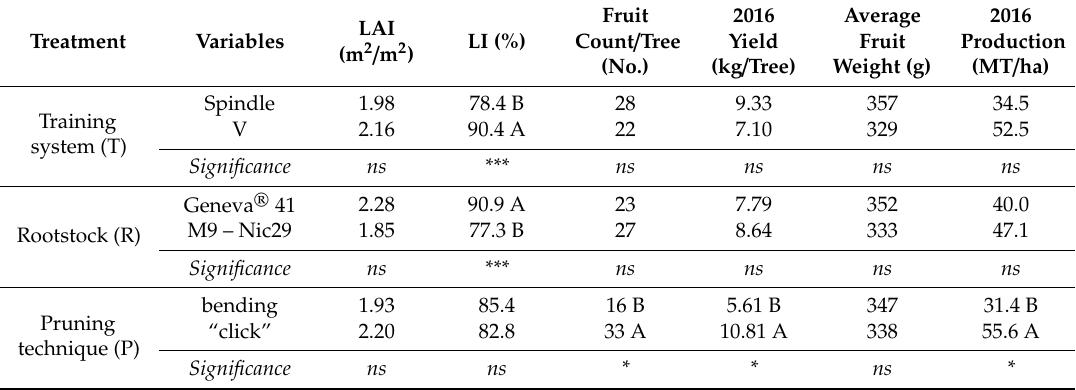
Table 1. The e ff ects of the training system, rootstock, and pruning technique on leaf area index (LAI) (m 2 / m 2 ), light interception (LI) fruit count (number of fruit / tree), yield (kg / tree), average fruit weight (g) and production (MT / ha) for “WA38” trees grown in Wenatchee area in Washington State in 2016. Treatment